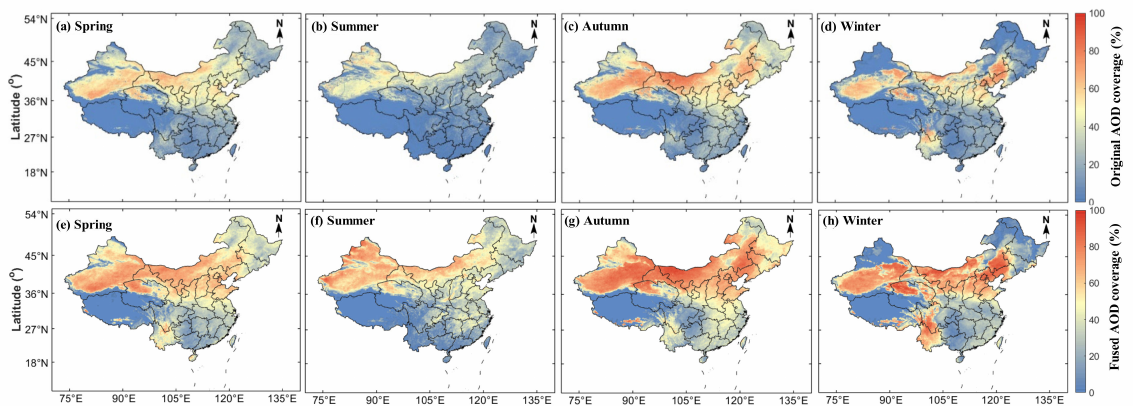
Figure 4. Maps of quarterly AOD coverage for original ( a – d ) and fused ( e – h ) MAIAC AOD. The color bar represents AOD coverage (%). Spring: March–May; Summer: June–August; Autumn: September–November; Winter: